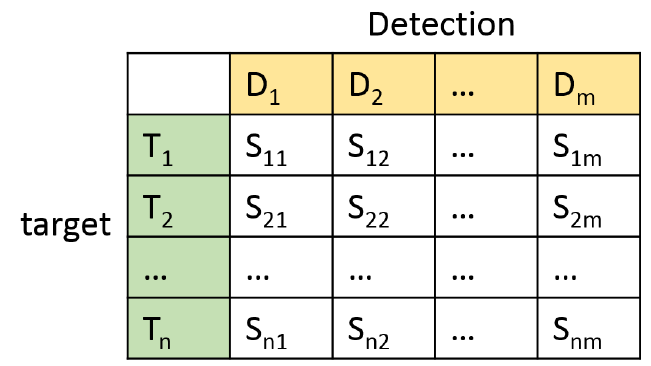
Figure 2. Distance matrix between the targets and detections. S ij measures the distance between the target T i and the detection D j .